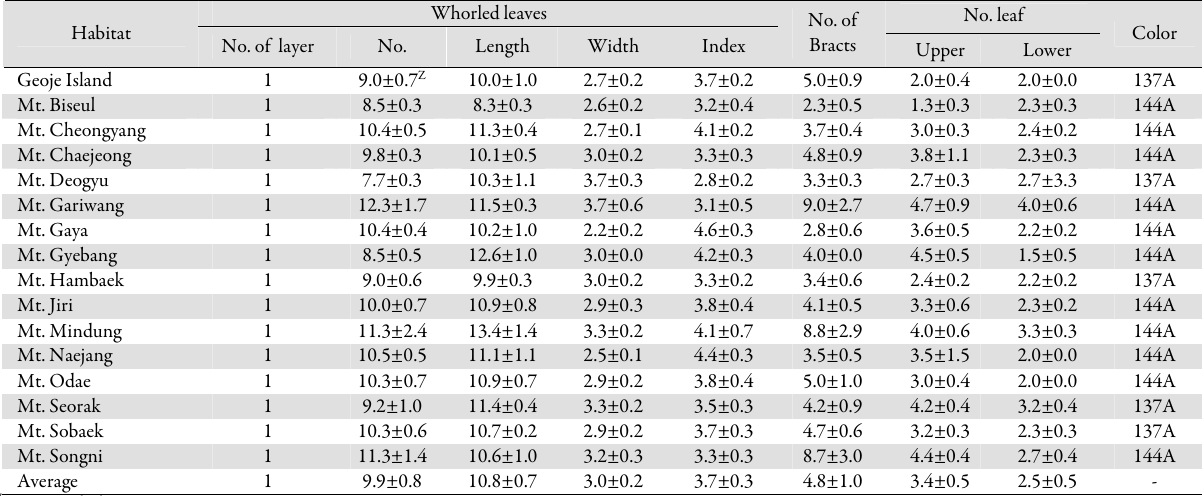
Tab. 4. Characteristics of stem of L. tsingtauense by region in Korea (n=20)